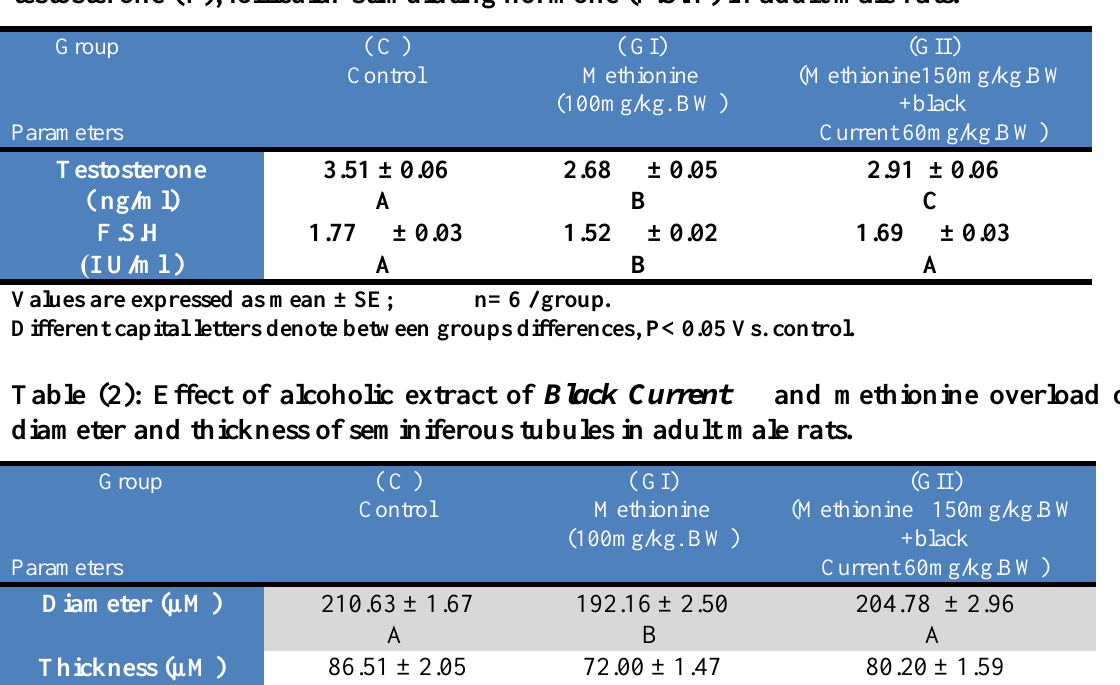
Table (1): Effect of alcoholic extract of Black Current and methionine overload on serum testosterone (T), follicular stimulating hormone (F.S.H) in adult male rats.